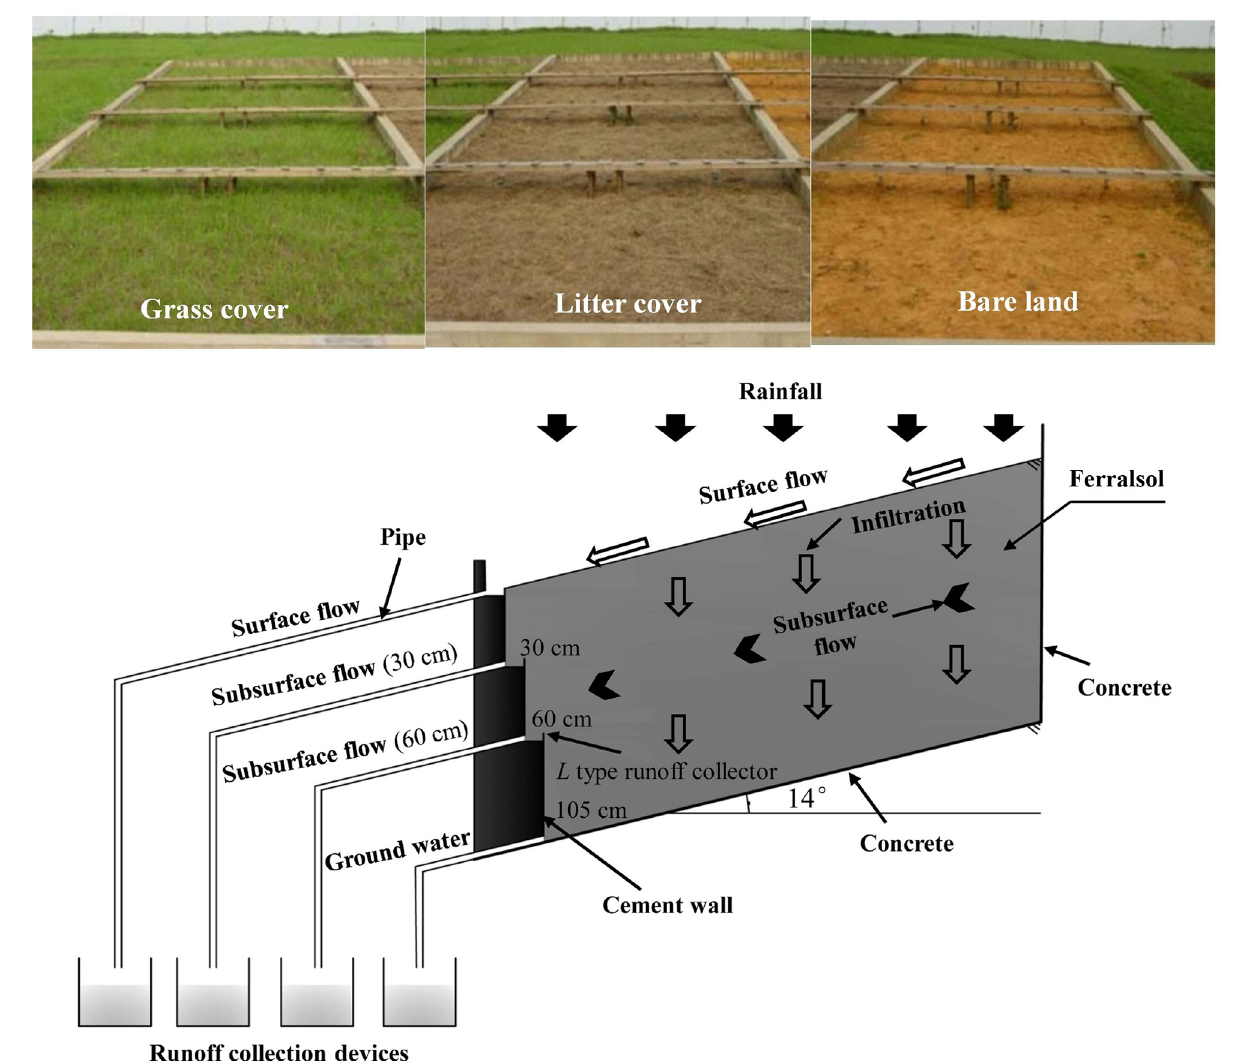
Fig 1. Schematic diagram of runoff generation in the three